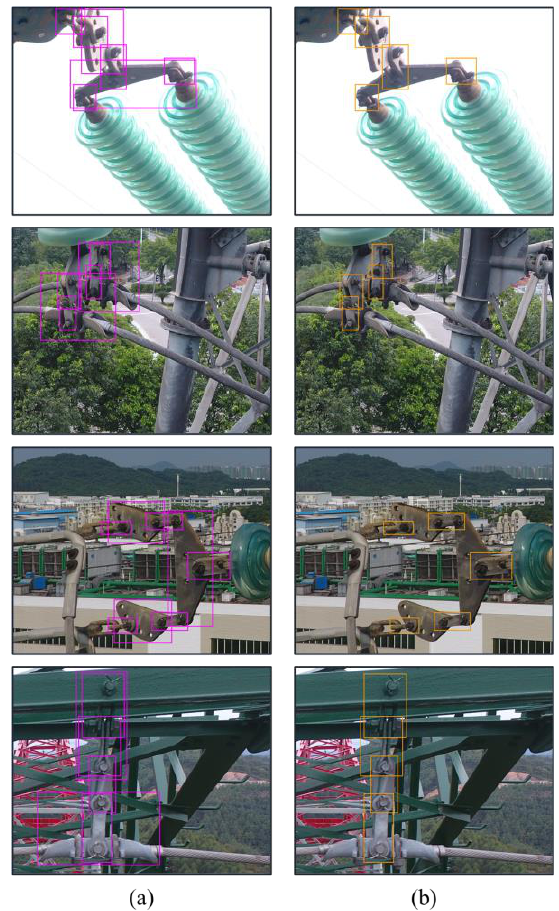
Figure 3 . Comparison of four pairs of the images labelled with different detection objects. Column (a) is the existing methods using the magenta boxes to label all kinds of link fittings, and column (b) is our method using the orange boxes to label eight specific link